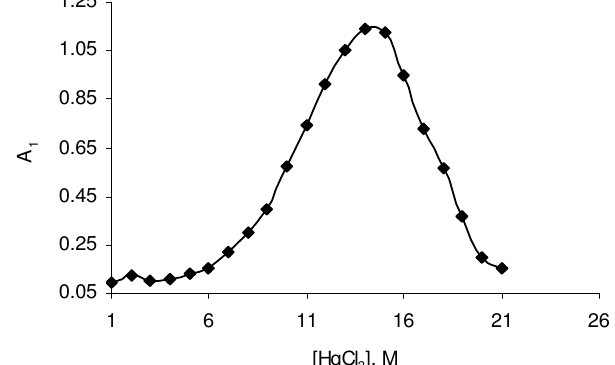
Figure 5. Dependence of the initial rate of substitution of CN - in [Fe(CN) 64- ] by EDTA on [HgCl ] at [Fe(CN) 64- ] =3.5 x 10 -3 M, [EDTA] = 3 x 10 -4 M, pH = 5, temp = 25 0 C and I = 2 0.1 M (KNO 3